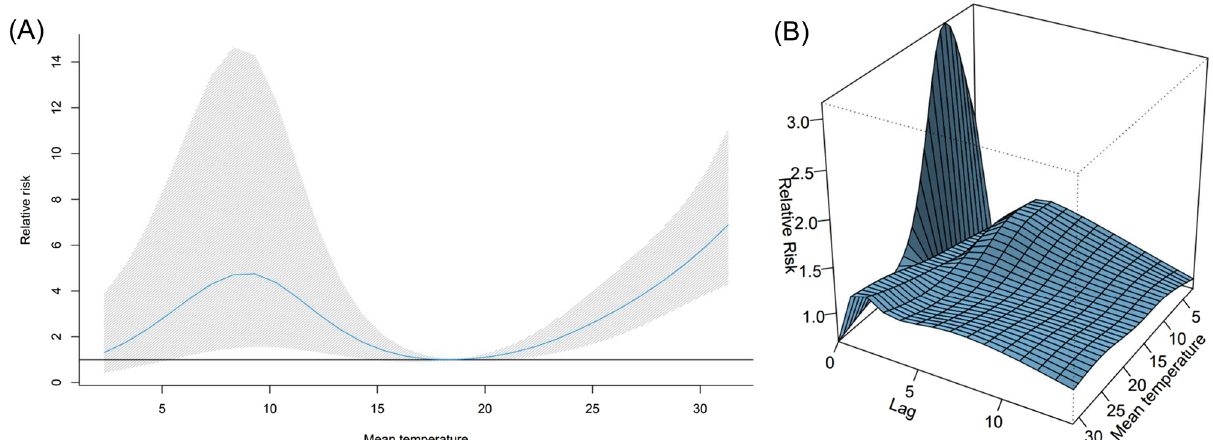
Figure 4. Overall and three-dimensional plots of relative risks with the reference at 18.6 °C. ( A ) The three- dimensional plot of the association between daily mean temperature (°C) and time-delay adjusted case fatality risks (CFR) over the lags of 14 days. The reference value of temperature was median temperature (18.6 °C). ( B ) The estimated overall effects of mean temperature (°C) over 14 days on CFR. Blue line shows the mean relative risks, and 95% confidence intervals are shown in the gray